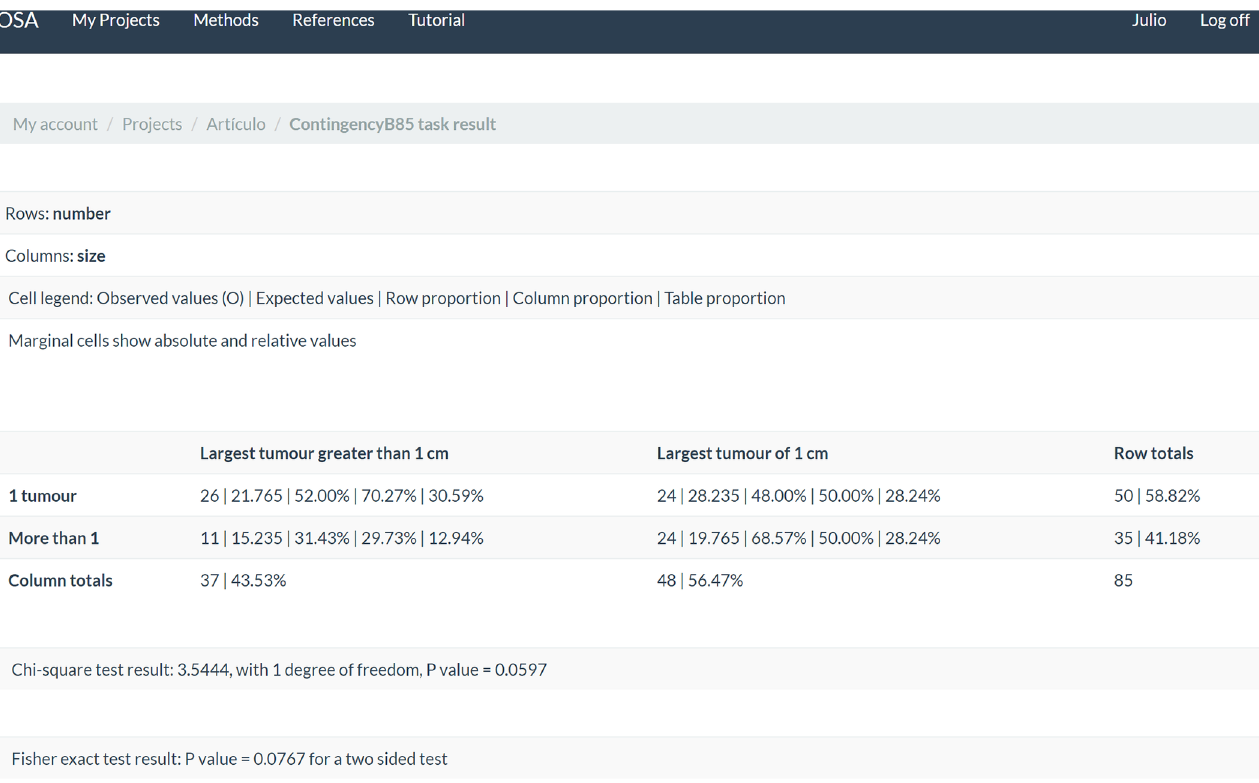
Fig 5. The contingency table generated by the application as it is shown on the web.